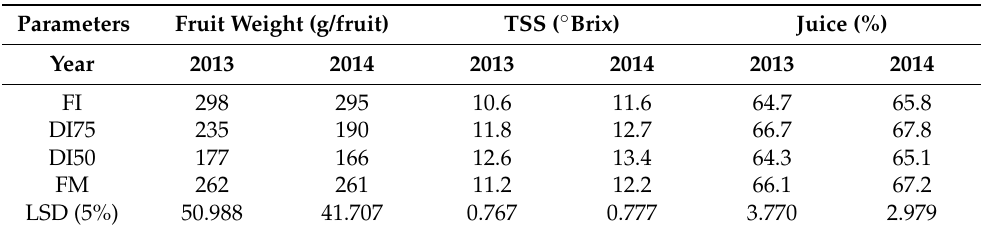
difference between treatments at p ≤ 0.05. TSS—total soluble solids